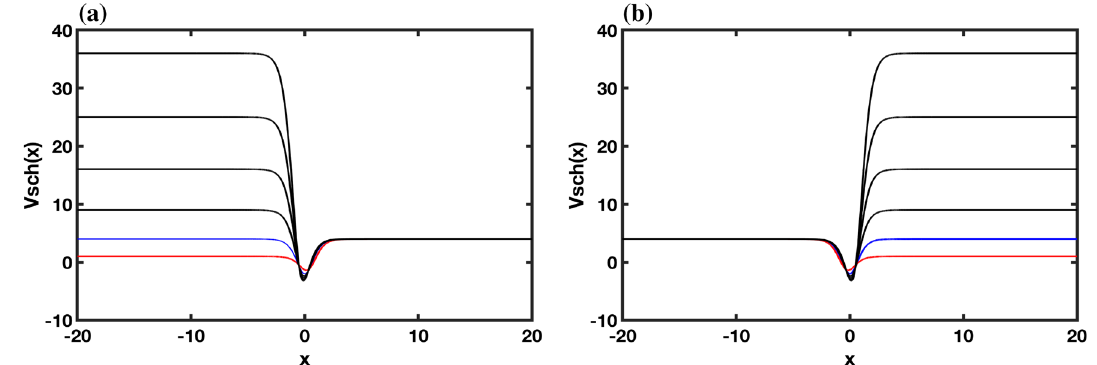
Fig. 2 The Schrödinger potential V sch ( x ) for a kink φ ( 0 , 1 ) n and b antikink φ ( 1 , 0 ) n . In all figures we fixed n = 1 (red solid), n = 2 (blue solid) and 3 ≤ n ≤ 6 (black line)